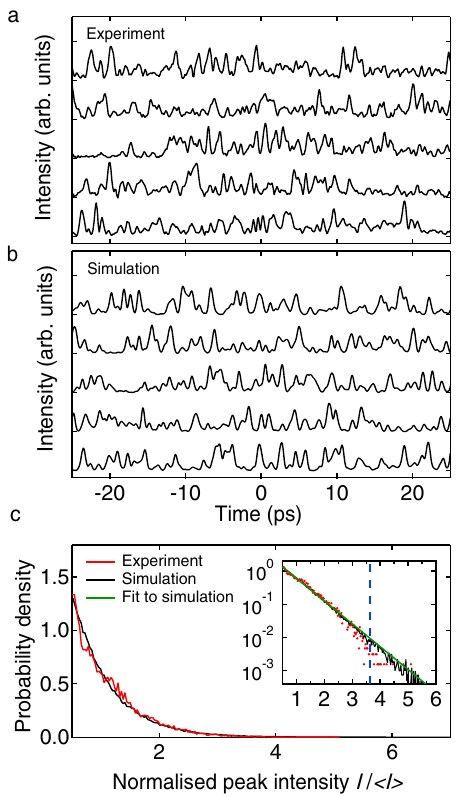
Fig. 6 Time lens results from experiment and simulation. Random intensity fl uctuations for 5 typical roundtrips at the HNLF input from a experiment, and b simulation. Experimental data show time-lens results plotted against time after scaling to account for the temporal magni fi cation. c Normalised probability density for the peak intensities from the experiment (red line) and simulation (black line). Both experiment and simulation are normalised relative to the mean of the intensity time series. The inset plots the probability density functions on a logarithmic scale to highlight quantitative agreement over 3 orders of magnitude, including the highest intensity peaks. The dashed blue line shows the computed rogue wave threshold from the experiment (which on this graph would coincide with that from simulation). The green line shows a fi t to a negative exponential distribution as discussed in the